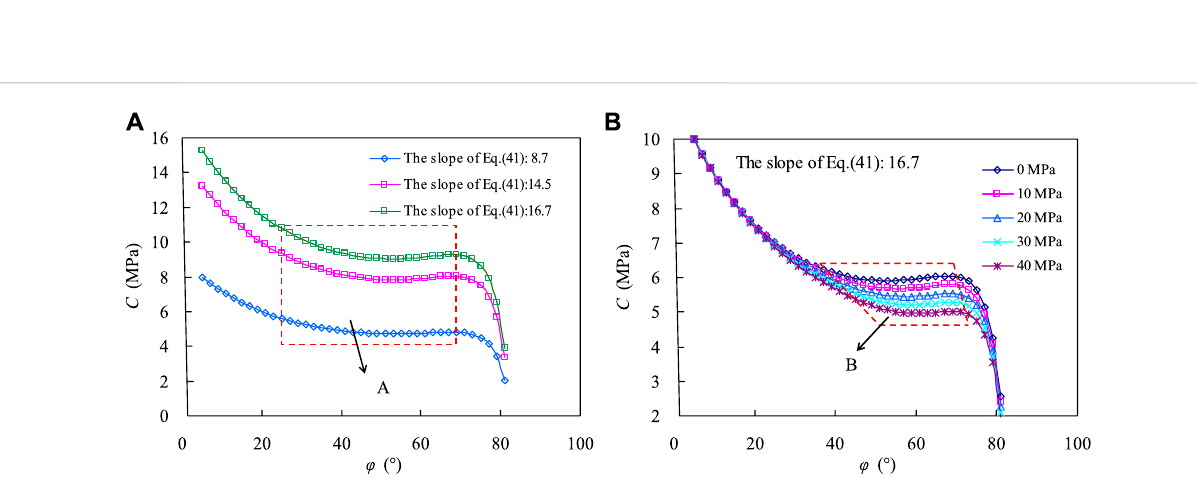
FIGURE 8 Variations of the estimated cohesion from the internal friction angle. (A) Different con fi ning pressures (B) different fl uid column